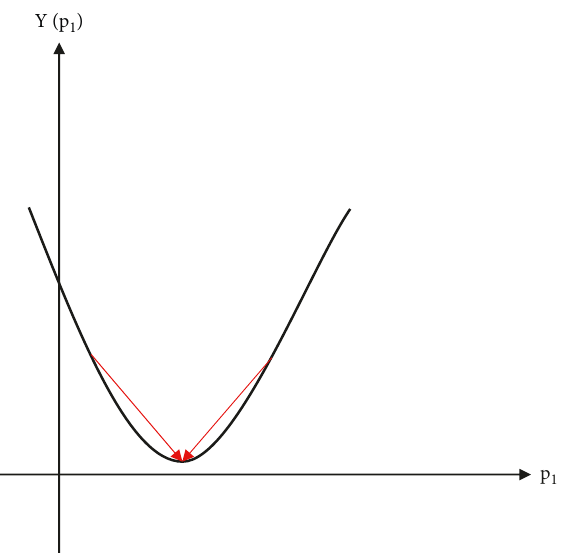
Figure 6: Potential function in the first case.